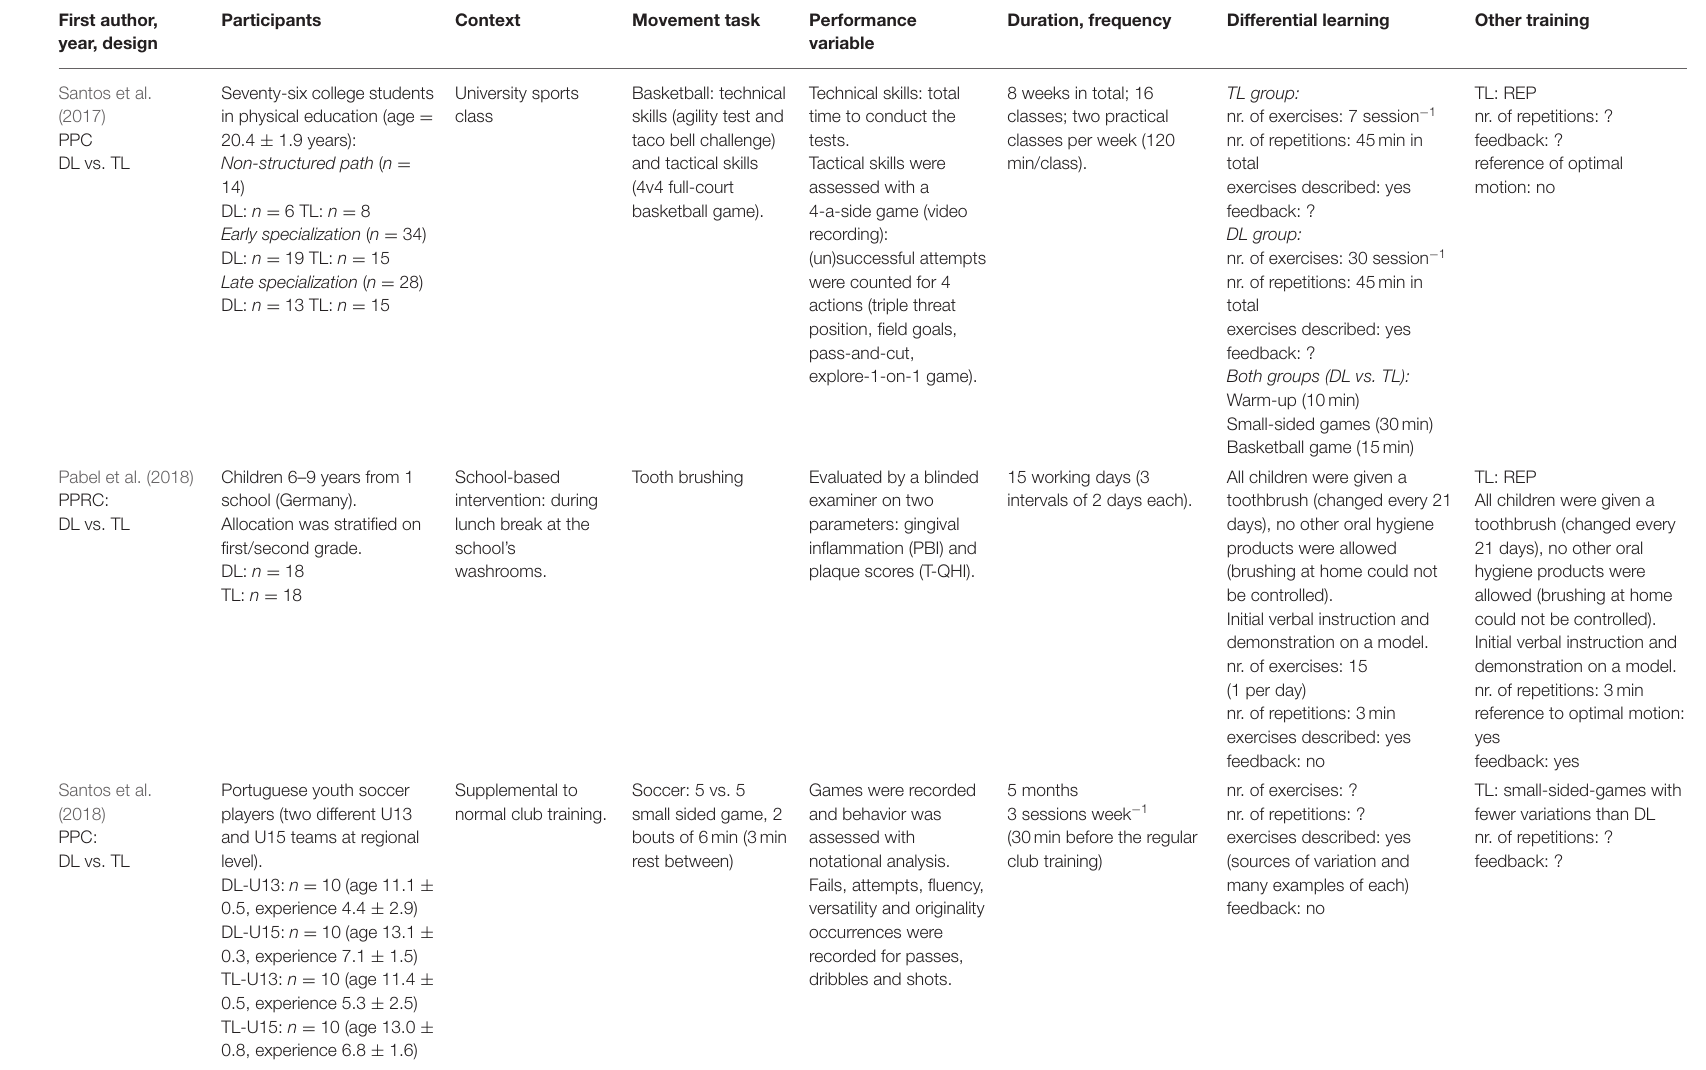
Supplemental to normal club training.